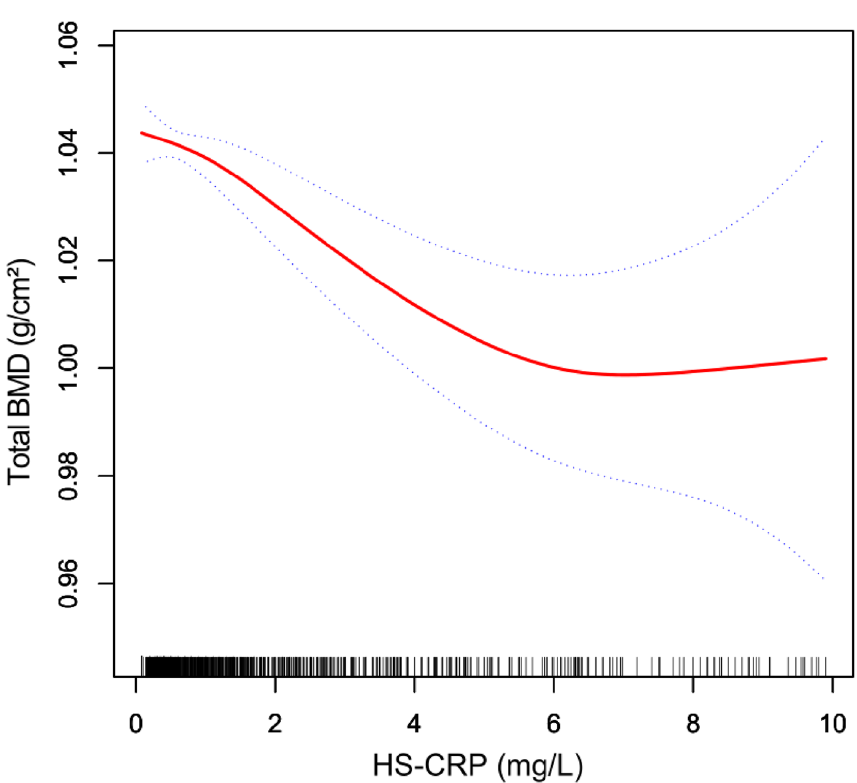
Figure 2. Correlation between HS-CRP and total BMD. Black points on the horizontal axis represent samples. The area between two blue dotted lines is expressed as a 95% CI. Each point shows the magnitude of the HS-CRP level and is connected to form a red continuous line. Age, gender, race, body mass index, income- poverty ratio, education level, alkaline phosphatase, cholesterol, calcium, phosphorus, globulin, and total protein were